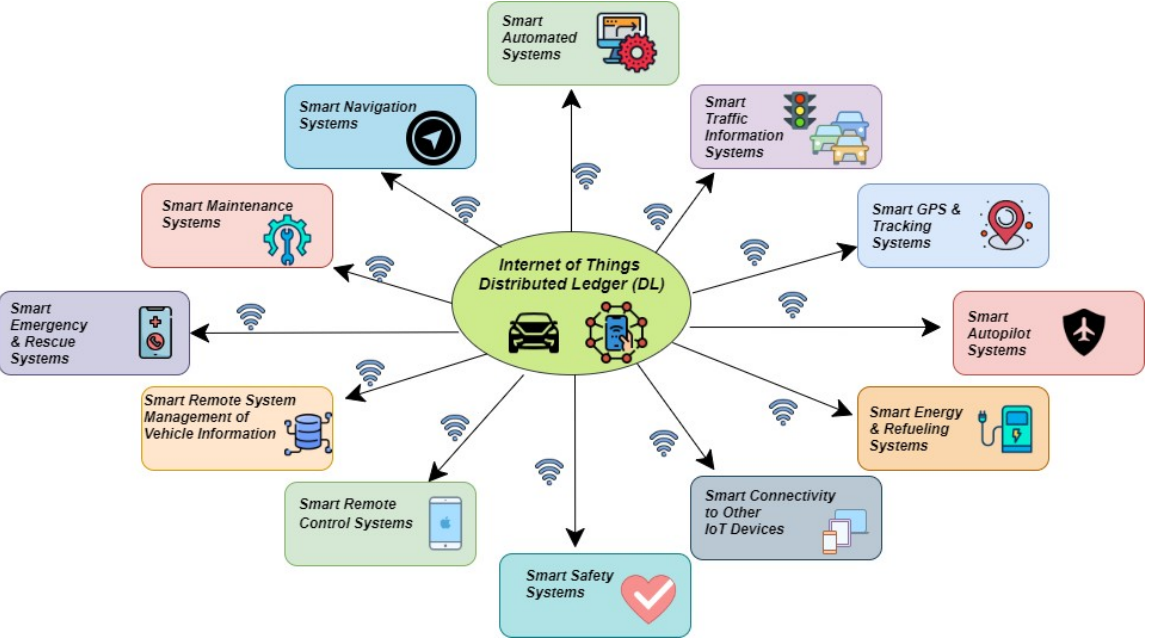
Figure 2. ITS Platform with IoT and blockchain in a generic setting.